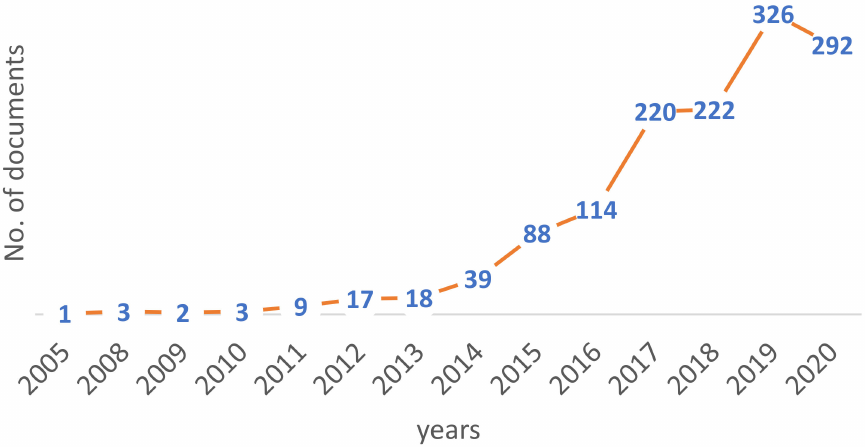
Figure 2. Number of documents published in the years